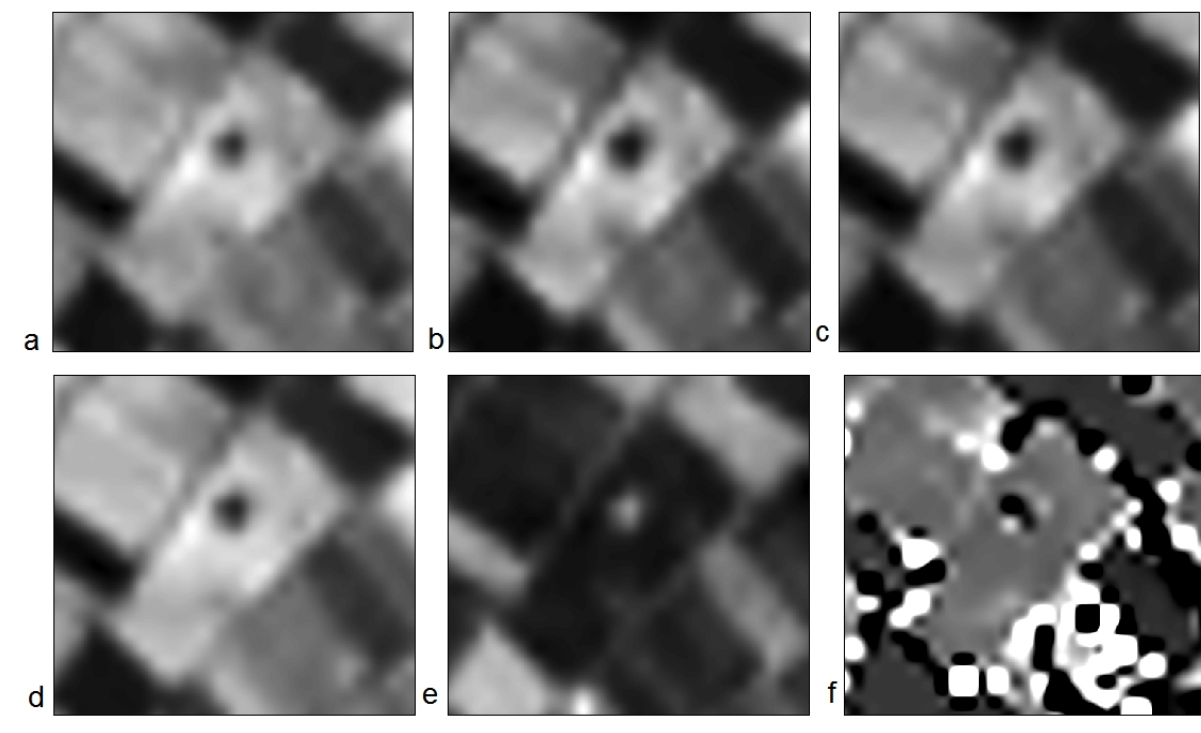
Figure 11. EO-1 HYPERION hyperspectral images used for the detection of the neolithic tell, Melia 2, at the Thessalian plain, after the application of narrowband indices: ( a )